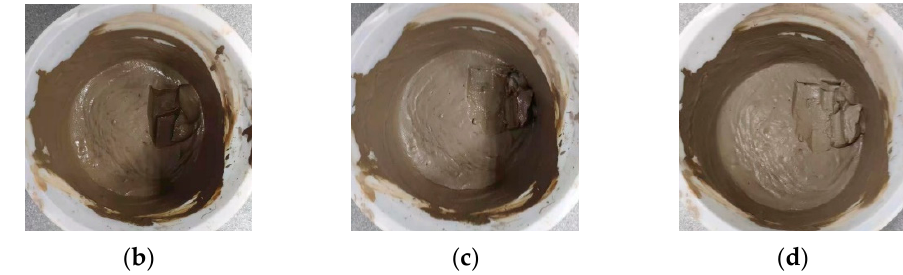
Figure 3. Curing effect of cement solidified soil: ( a ) After 0.5 h; ( b ) After 1 h; ( c ) After 3 h; ( d ) After 6 h.